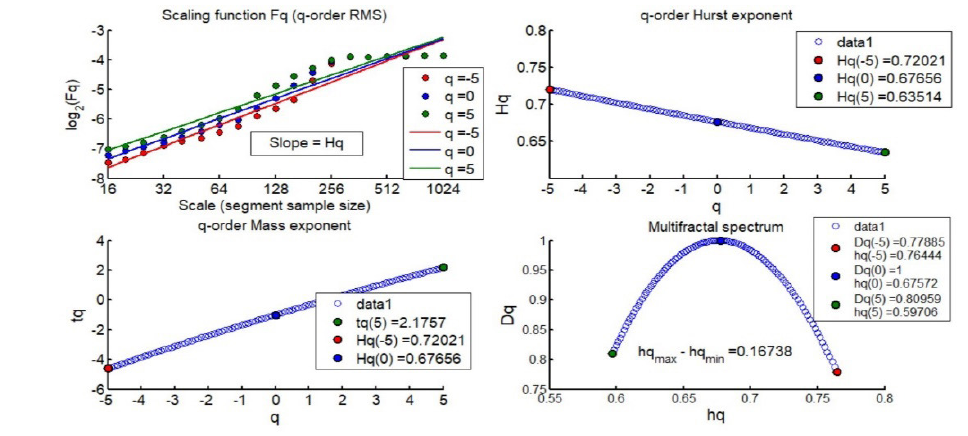
Figure A8. Hurst exponent value Hq (5) in 2018